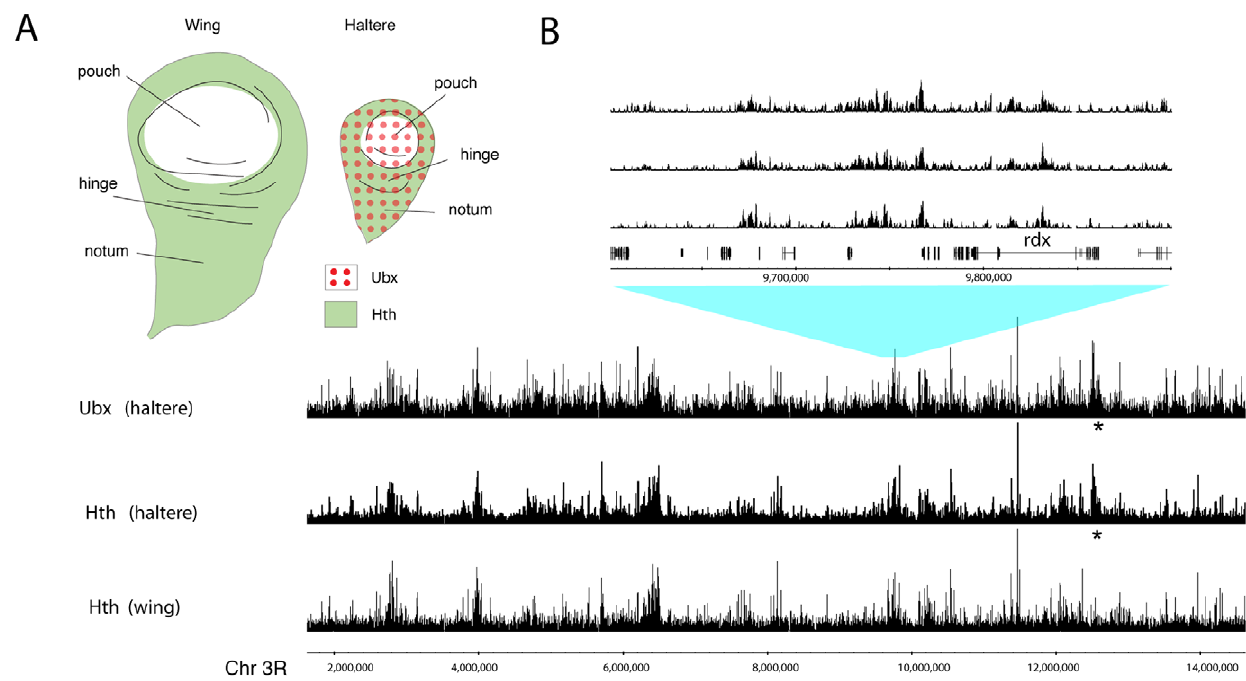
Figure 4. Comparison of Ubx and Hth binding profiles. (A) Schematic of Ubx and Hth expression in the wing and haltere discs. The wing disc pouch region gives rise to the wing blade and the haltere pouch region gives rise to the haltere capitellum. We use the term haltere hinge to encompass the pedicel and scabellum. (B) Log 2 enrichment ratio profiles for Ubx and Hth on representative regions from chromosome 3R. The peaks at approx 12,500,000 (asterisk) present in the haltere profiles and absent in the wing are associated with the Ubx gene (see Figure 7).